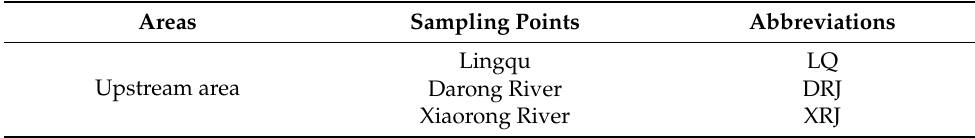
Table 1. Distribution of sampling